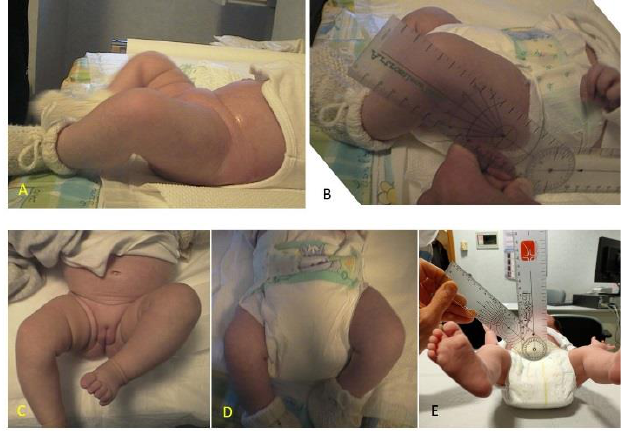
Figure 2. Hip position in a 2-month old infant: ( A ) evaluation of hip flexion without diaper; ( B ) with double diapers. Measurements with a of hip flexion angle with protractor: ( C ) evaluation of hip abduction without diaper; ( D ) with double diapers; ( E ) measurement of abduction with protractor.